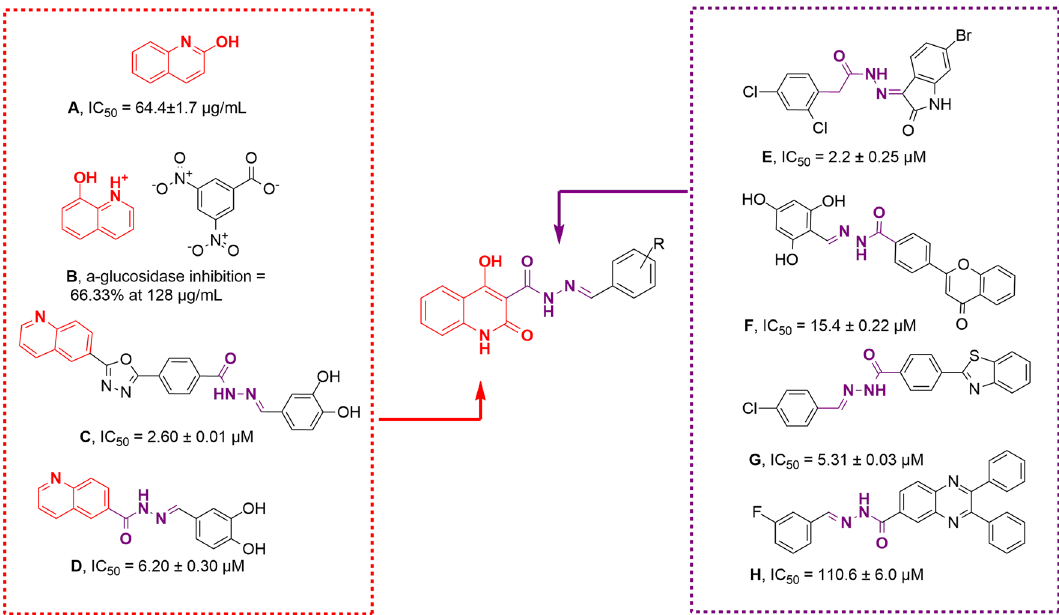
Figure 1. The rationale for the design of 4-hydroxyquinolinone hydrazone hybrids as new α-glucosidase